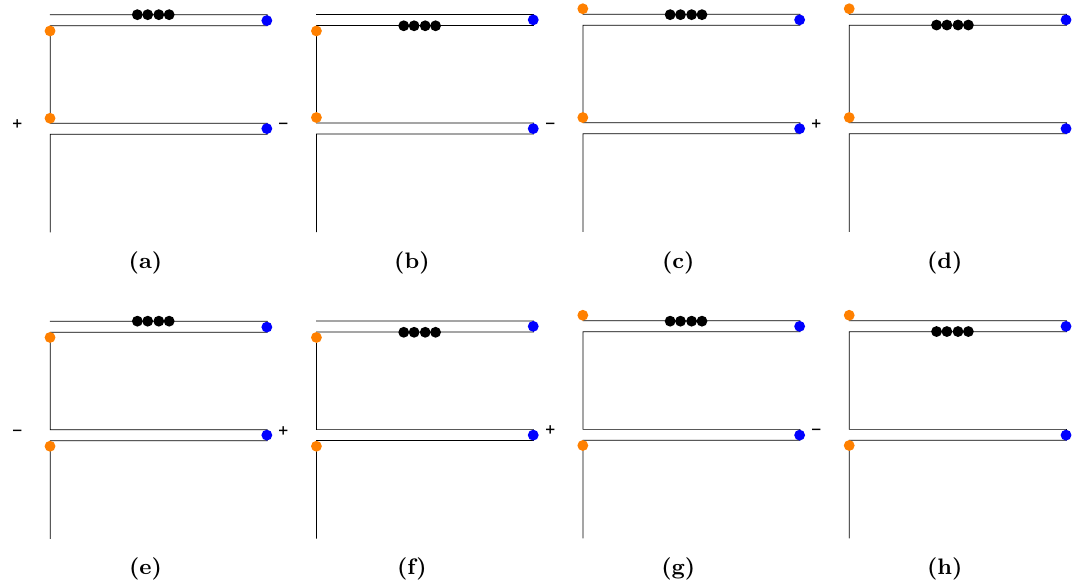
Figure 2. The eight configurations of the commutator-squared OTOC. The four black dots repre- sent the interaction